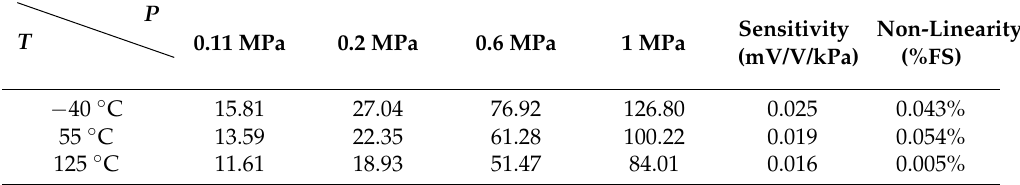
Table 4. Outputs of pressure sensor without a shield layer versus temperature ( T ) and pressure ( P ).